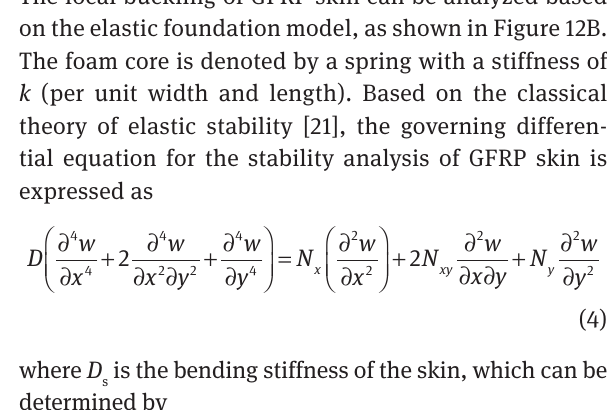
Table 4. For the specimens with 1000 mm effective height, the values of μ ranged from 1.08 to 1.90. Compared to Specimen WP1 ( μ = 1.19), it can be observed that the values of μ for Specimen WP3 strengthened with 4.8-mm-thick webs and Specimen WP4 strengthened with 4.8-mm-thick skins increased by 52.4% and 26.4%, respectively. Hence, using thicker web and skin can enhance energy dissipa- tion ability. The same phenomenon was also observed for those specimens with 1600 mm effective height. Compared to Specimen WP6 ( μ = 1.54), it can be seen that the values of μ for Specimen WP8 strengthened with 4.8-mm-thick webs and Specimen WP7 strengthened with 4.8-mm-thick skins increased by 23.6% and 5.6%, respectively. The effect of web spacing on the energy ductility coefficient could be analyzed by comparing Specimens WP1 and WP2. The web spacing of Specimen WP2 ( μ = 1.46) was 120 mm